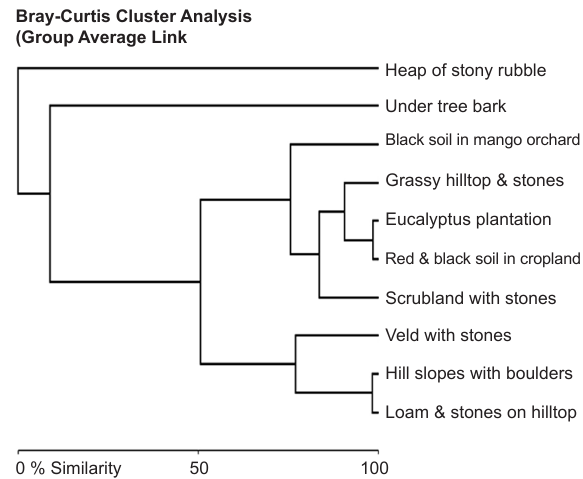
= 7.36, Km = Figure 3. Dendrogram showing the results of cladistic max analysis by Bray-Curtis method for comparison of species composition in various microhabitats in the study area to depict the β